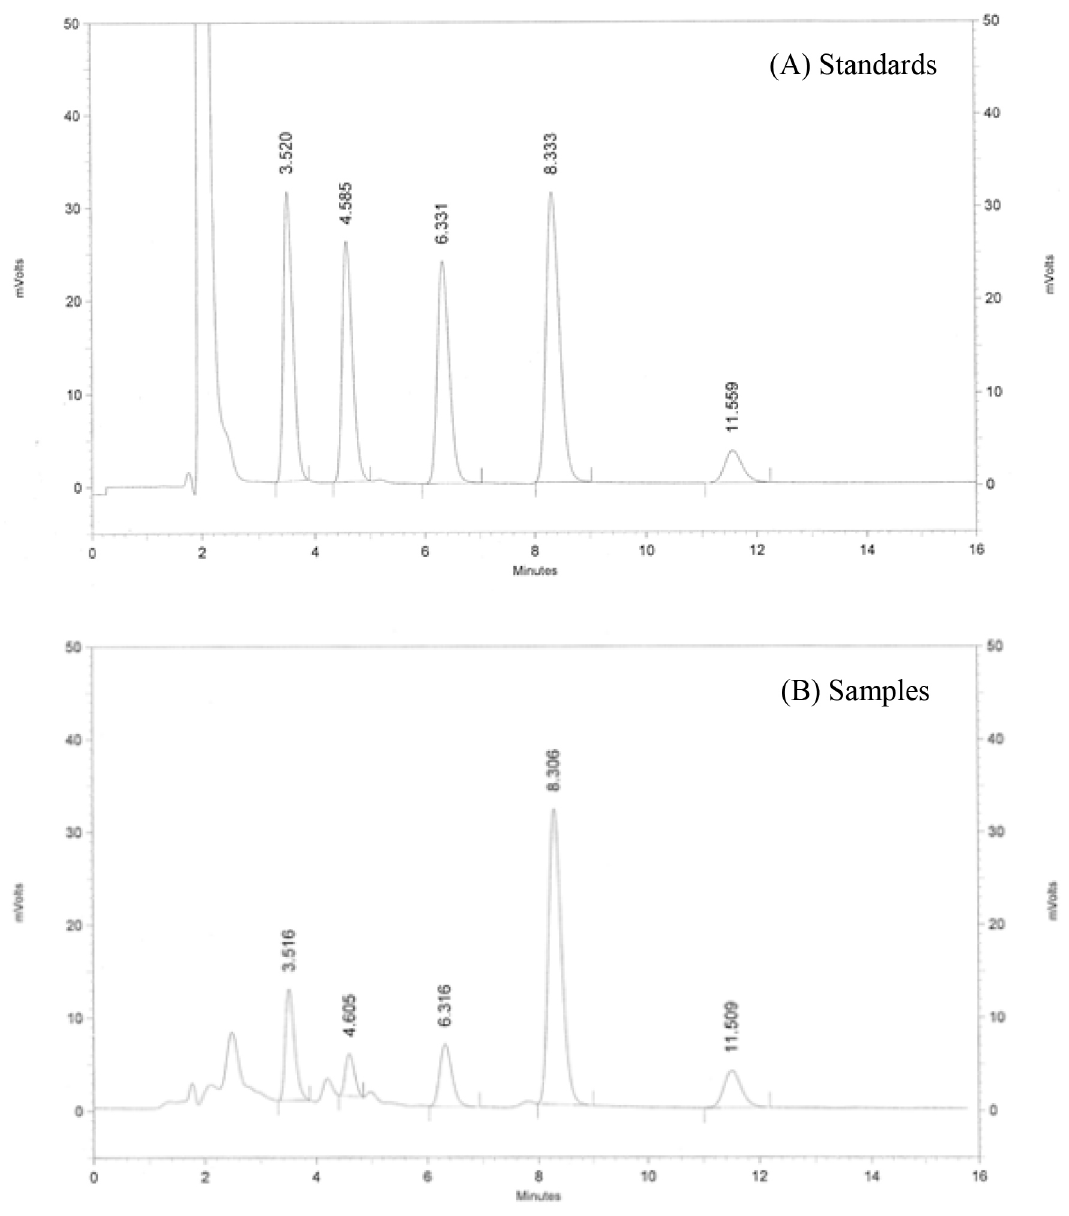
FIGURE 1 - High-performance liquid chromatography (HPLC) chromatograms of Standards (A) and Samples (B). 1. Aloe- emodin (t = 3.516 min); 2. Rhein (t R (t = 11.509 R